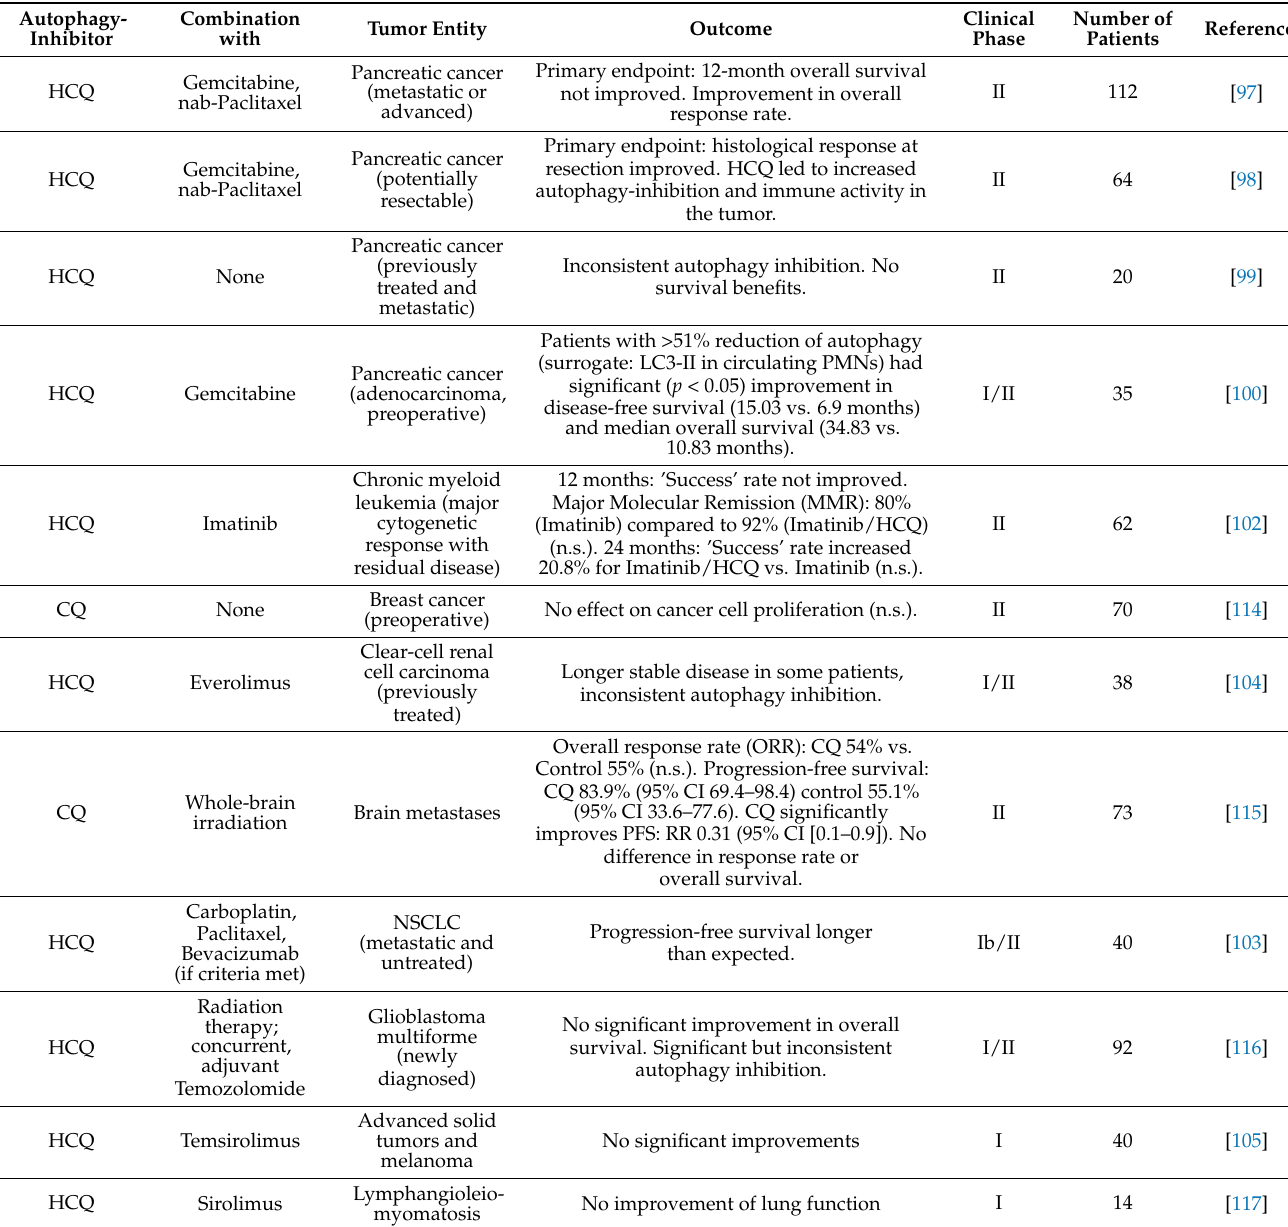
Table 2. Selected clinical studies with published